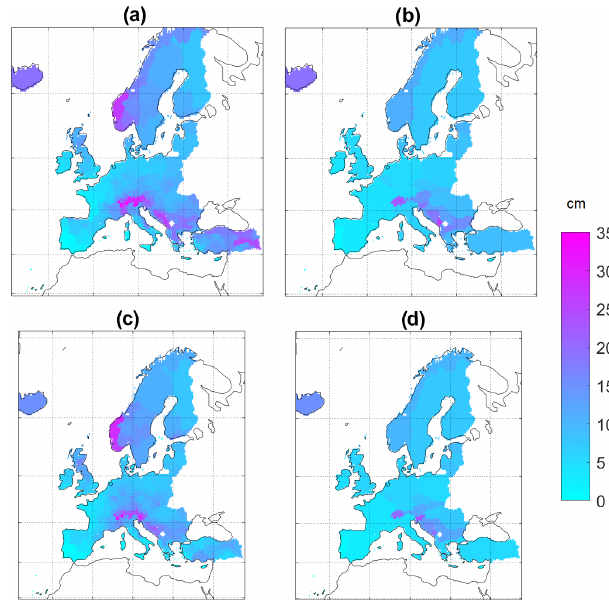
Figure 2. Maximum yearly snowfall (SF; average 1979–2018) for the ERA5 (a, b) and the E-OBSv20.0e (c, d) datasets. (a,c) NUTS-0 level, (b, d) NUTS-2 level.